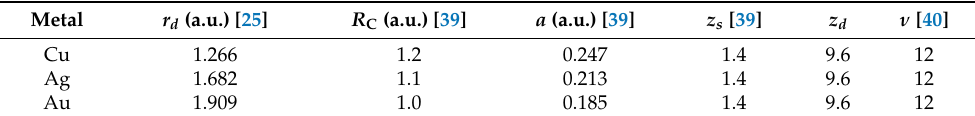
Table 2. Input data used for calculations.